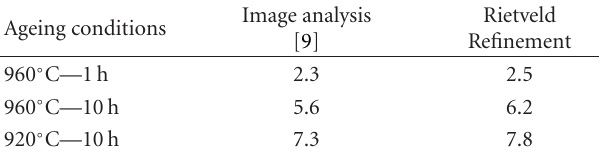
Table 3: Volume fraction (%) of delta phase after di ff erent ageing treatments obtained by image analysis [9] and by Rietveld refine- ment.